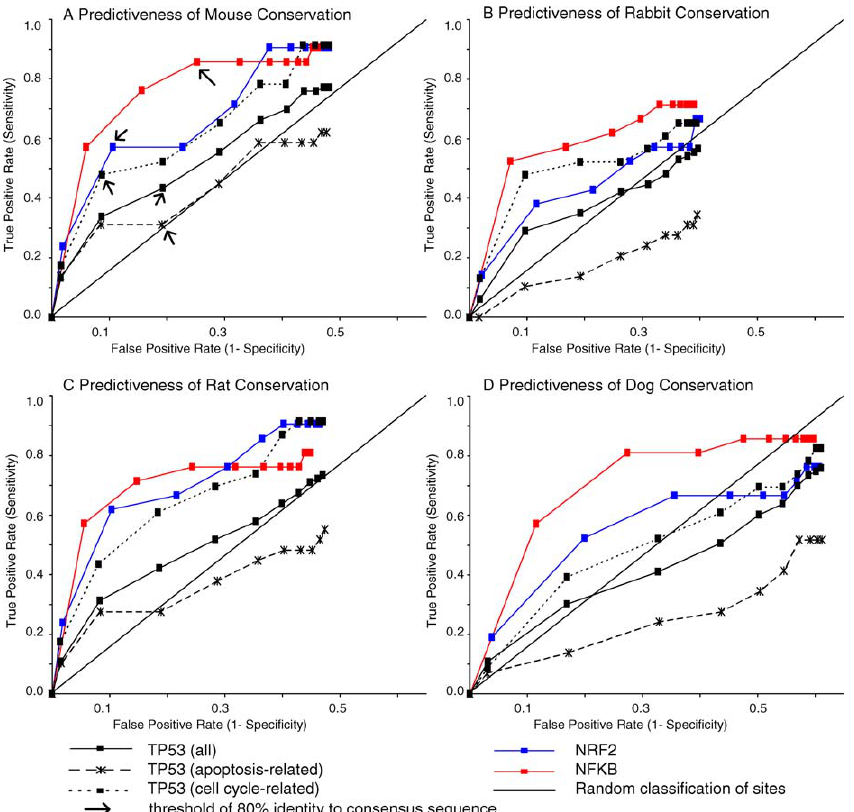
Figure 3. ROC Curves for Four Mammalian Comparisons Indicate the Ability of Different Interspecific Comparisons to Identify Bona Fide Human TFBSs (A–D) Using a dataset of experimentally verified human TFBSs and randomly chosen promoter sequences from human genes, the true positive and false positive prediction rates were calculated given conservation thresholds that classify a TFBS as authentic or spurious. Each data point on a curve represents a different conservation threshold for comparison in the indicated species. In (A) arrows indicate the 80% identity threshold. For NF j B 80% identity with mouse is highly predictive for human. Prediction of apoptosis sites are similar to random classification (diagonal line).